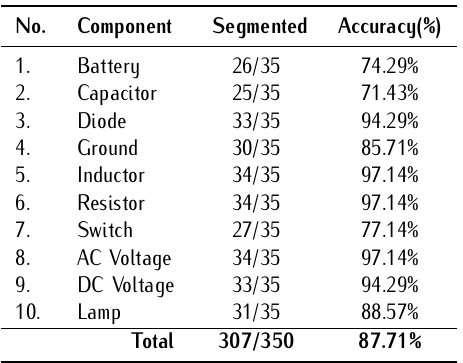
Table 1. Segmentation Accuracy of Components